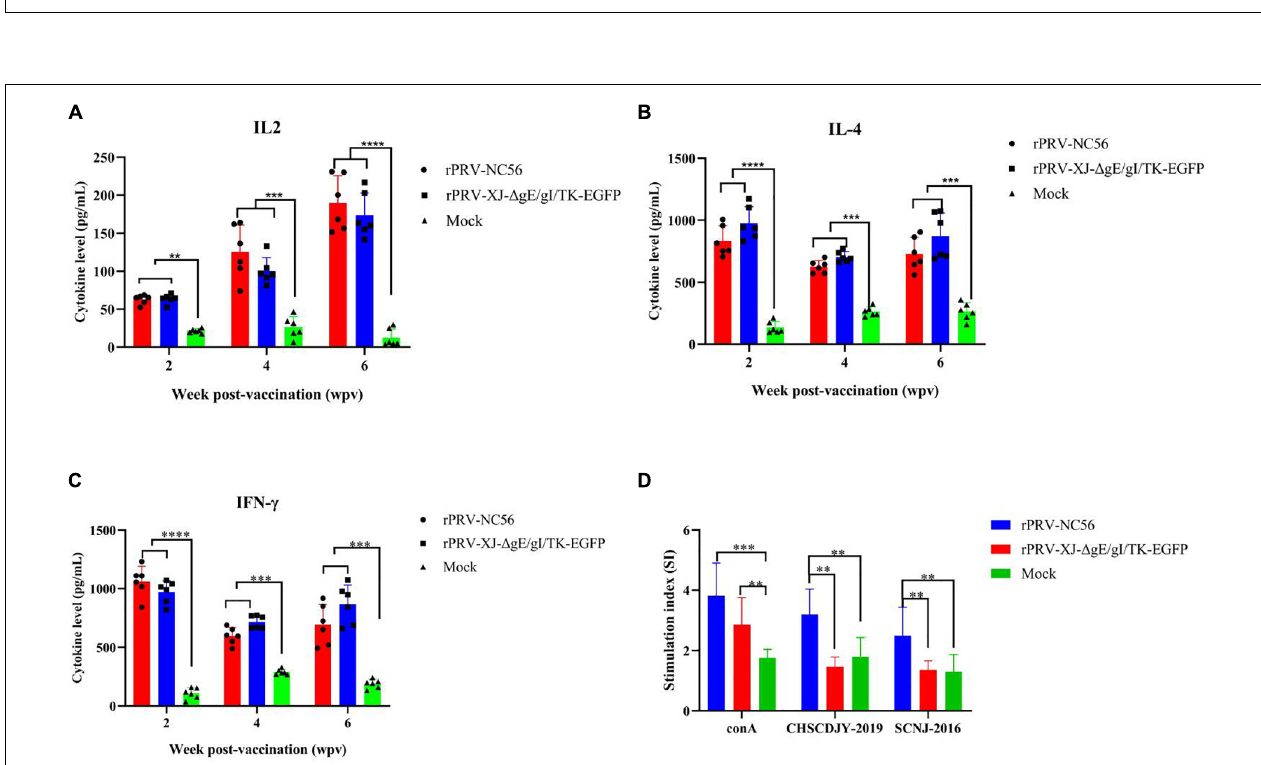
FIGURE 8 | The T cellular response analyses of blood sample from rPRV XJ- (cid:49) gE/gI/TK-EGFP, rPRV-NC56, and nonvaccinated groups. (A) Plasma IL-2 was detected by ELISA. (B) Plasma IL-4 was detected by ELISA. (C) Plasma IFN- γ was detected by ELISA. (D) Splenic lymphocytes were assayed for T-cell-specific proliferative responses using the MTT kit. ∗ p < 0.05; ∗∗ p < 0.01; ∗∗∗ p < 0.005; and ∗∗∗∗ p < 0.001.